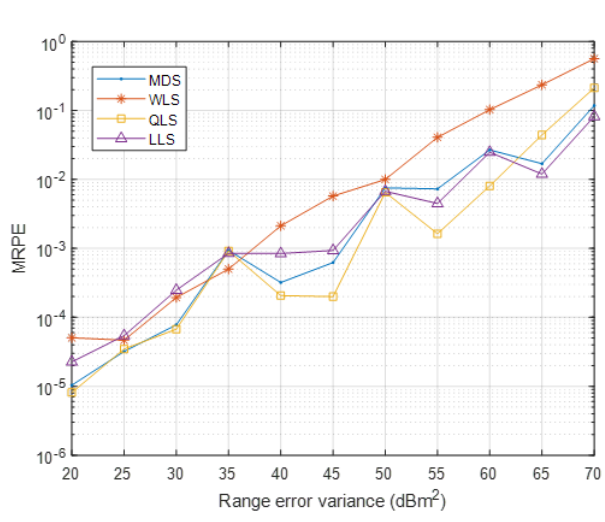
Figure 17. Algorithm performance comparison (MSPE and MRPE for three-BS geometry without NLOS). From the figures, it can be noticed that the two-step WLS algorithm has the best performance compared to other methods